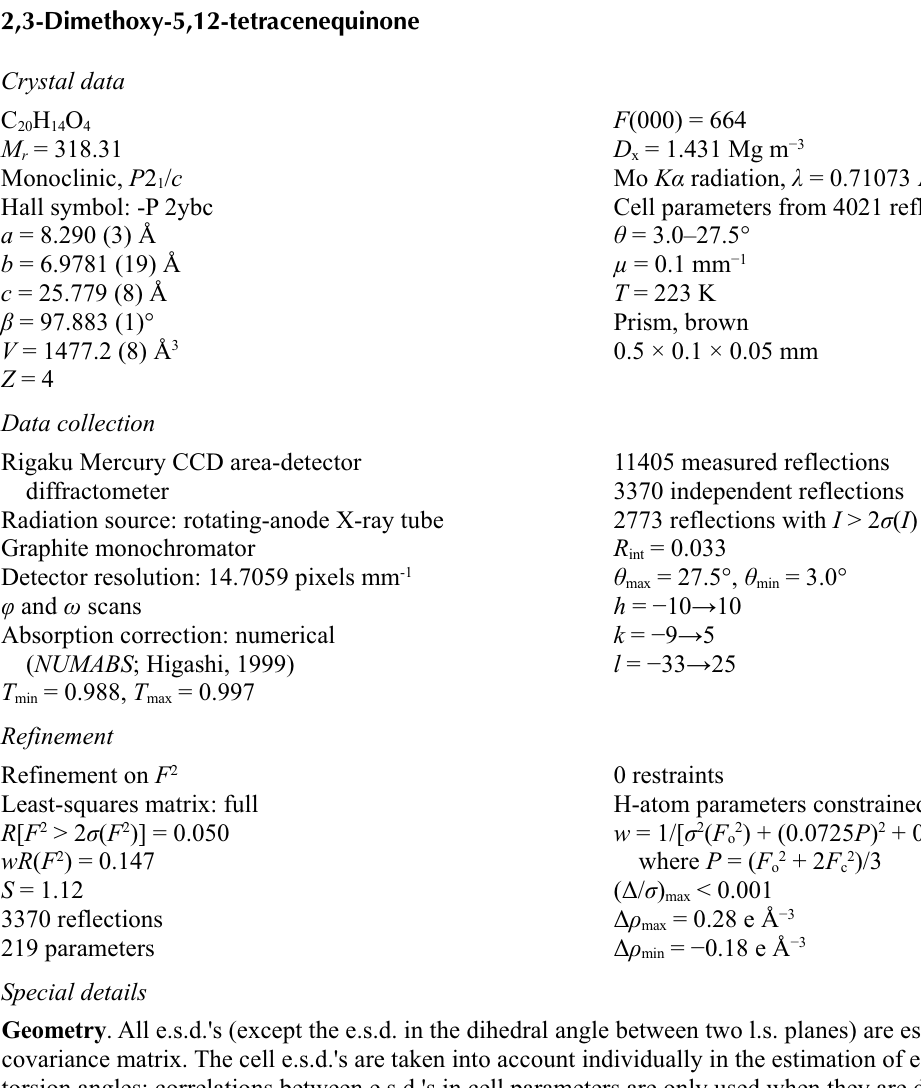
Figure 2 The packing diagram of the title compound. C-H···O interactions are shown with dashed